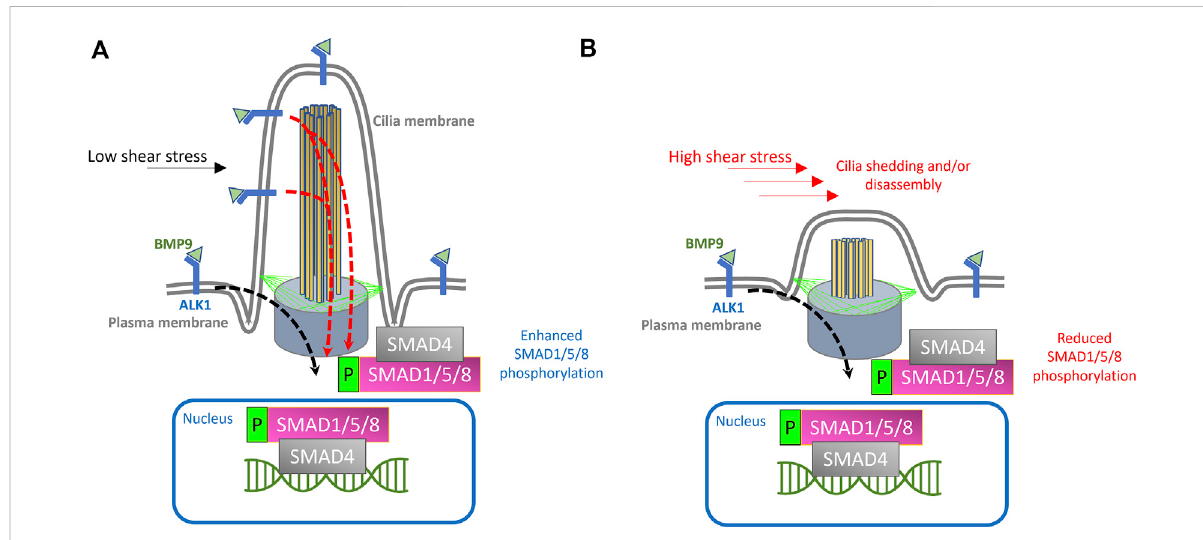
FIGURE 1 Proposed model for endothelial cilia mediated BMP/ALK1/SMAD signaling. (A) Schematic depiction of endothelial primary cilium, showing microtubule-based axoneme (yellow rods), basal body (purple cone), transition fi bers (green lines) and cilia membrane (labeled). In the proposed model, ALK1 is enriched both at the plasma membrane and at the ciliary membrane. BMP9 is available under low shear stress conditions through circulationandbindstoALK1intheECmembraneandattheciliarymembrane.Underlowshearstress,thebindingofBMP9toALK1willresultin thephosphorylationofSMAD1/5/8andtranslocationofSMAD4+phosphorylatedSMAD1/5/8complextothenucleus,wherethiscomplexwillactas a transcription factor to drive the expression of genes required for pericyte recruitment and vessel stabilization, giving rise to stable arteriovenous connections. (B) Exposure to high shear stress would result in cilia disassembly or dysfunction, thereby curtailing cilia mediated ALK1 signaling and downstream